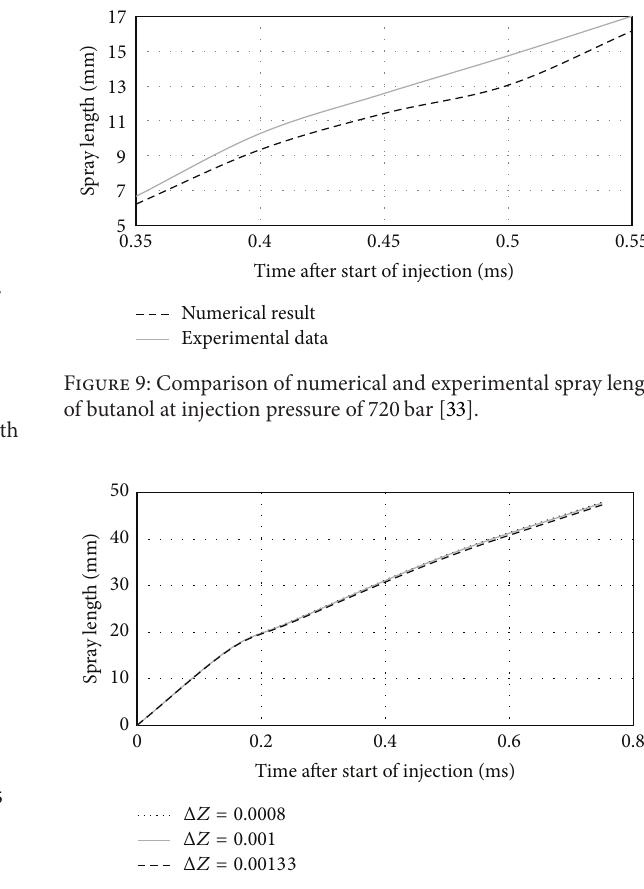
Figure 10: Resolution sensitivity analyses of B5 spray length at injection pressure of 600 bar.